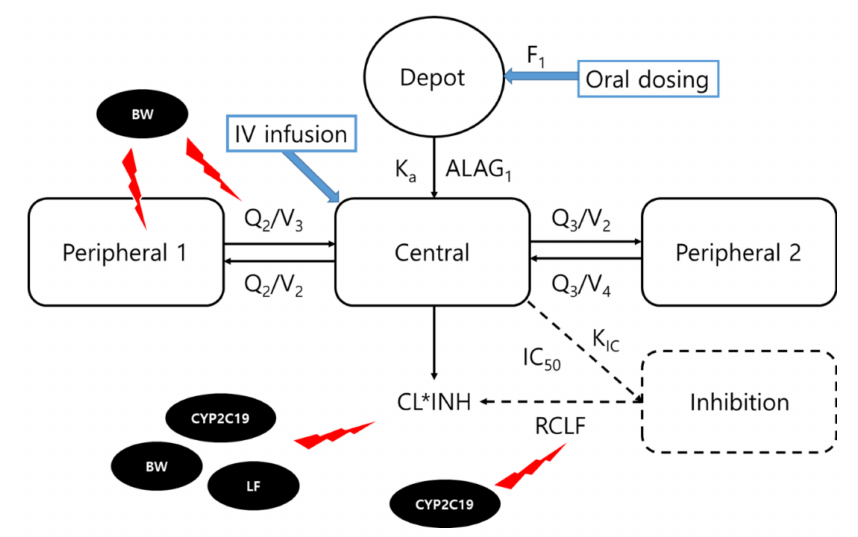
Figure 1. Structure of the population pharmacokinetic model for voriconazole concentrations and significant covariates. Clearance (CL) is inhibited based on the concentration in an empirical inhibition compartment. C Inh corresponds to the concentration in the inhibition compartment. INH corresponds to [RCLF + (1 − RCLF) × (1 − C Inh /(IC 50 + C Inh ))]; F 1 , bioavailability; K a , absorption rate constant; ALAG 1 , absorption lag-time; V 2 , central volume of distribution; Q 2 and Q 3 , inter-compartmental clearance; V 3 and V 4 , peripheral volume of distribution; K IC , rate constant into inhibition compartment; RCLF, remaining CL fraction, i.e., fraction of clearance which cannot be inhibited; IC 50 , concentration in the inhibition compartment yielding 50% of maximum clearance inhibition; IV, intravenous; BW, body weight; LF, liver